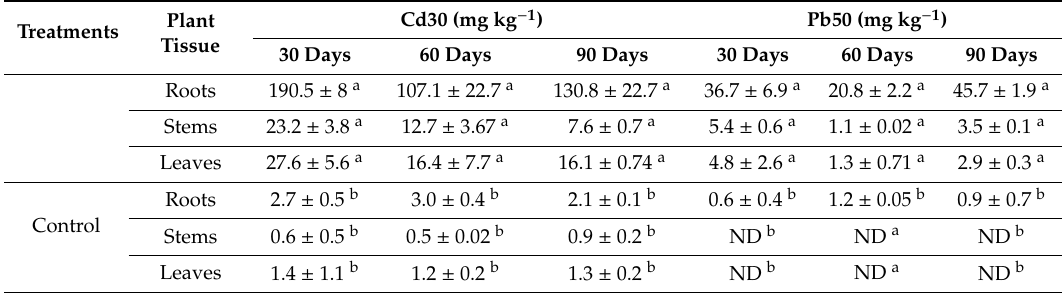
Table 1. The concentration of Cd and Pb (mg kg − 1 ) in the organs of P. fasciculatum grown in doped mining soils.